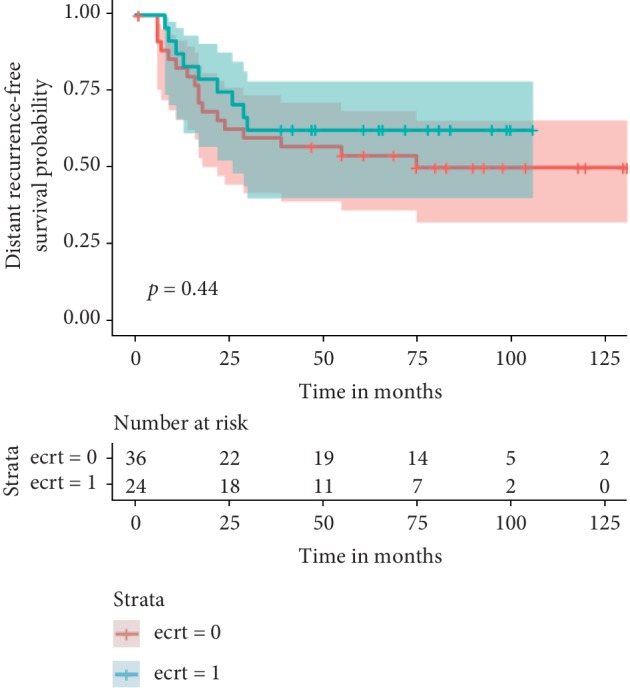
Kaplan‐Meier curves showing distant recurrence-free survival stratified by use of reimplantation. Green line with reimplantation of tumor bone and the red without. Time is in months.